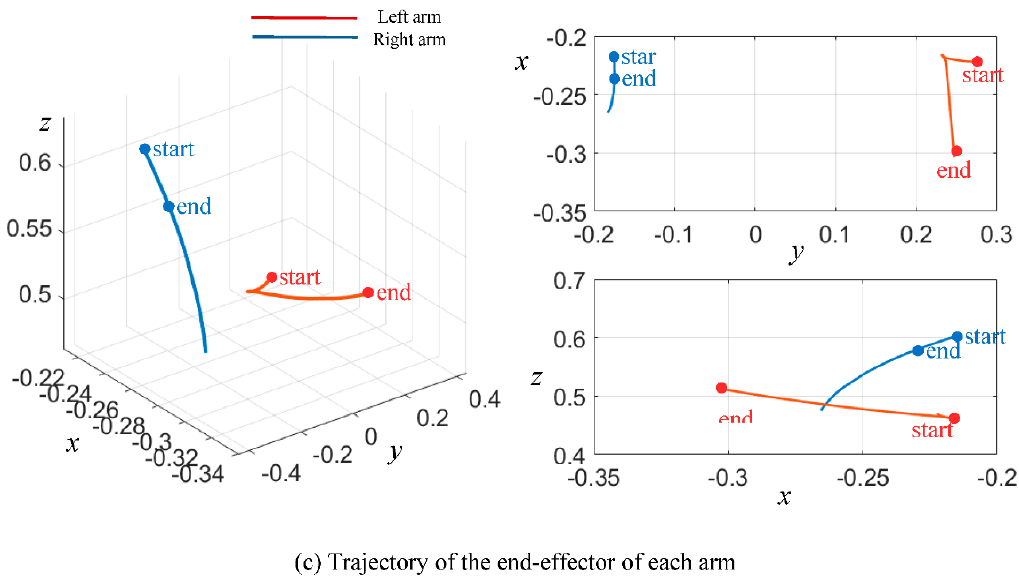
Figure 12. Experiment to assess the ability of the dual-arm system to avoid self-collision when the left and right arms had di ff erent targets. ( a ) Two arms of the dual-arm robot have di ff erent targets; The experiments are illustrated in two views; ( b ) Velocity profile of the end-e ff ector of each arm; ( c ) Trajectory of the end-e ff ector of each